Question: In one sentence, what is this figure communicating?
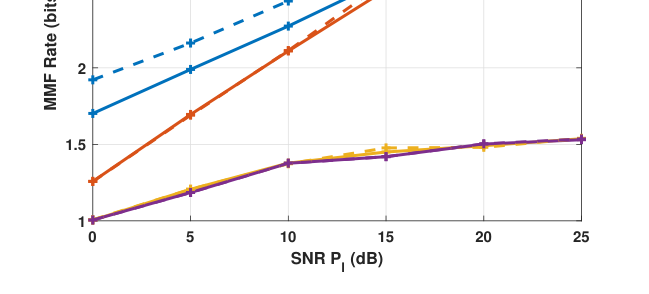
Answer: MMF rate versus LEO SNR Pl for different GEO SNR Pg and network loads. Ntg = 4, Ntl = 3, M = 2, N = 6, K = 8.